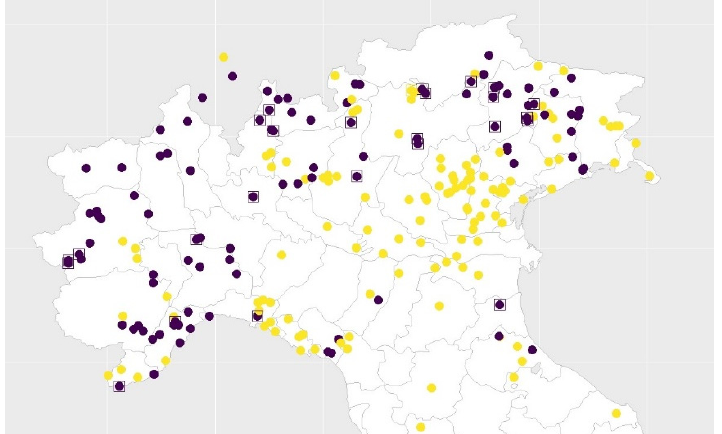
Figure 1. The presence or absence of doubling of the subject who . Dataset: Manzini and Savoia (2005) + selected data points from the ASIt database. Legend: absence of doubling vs. presence of doubling (squares: in clefts).